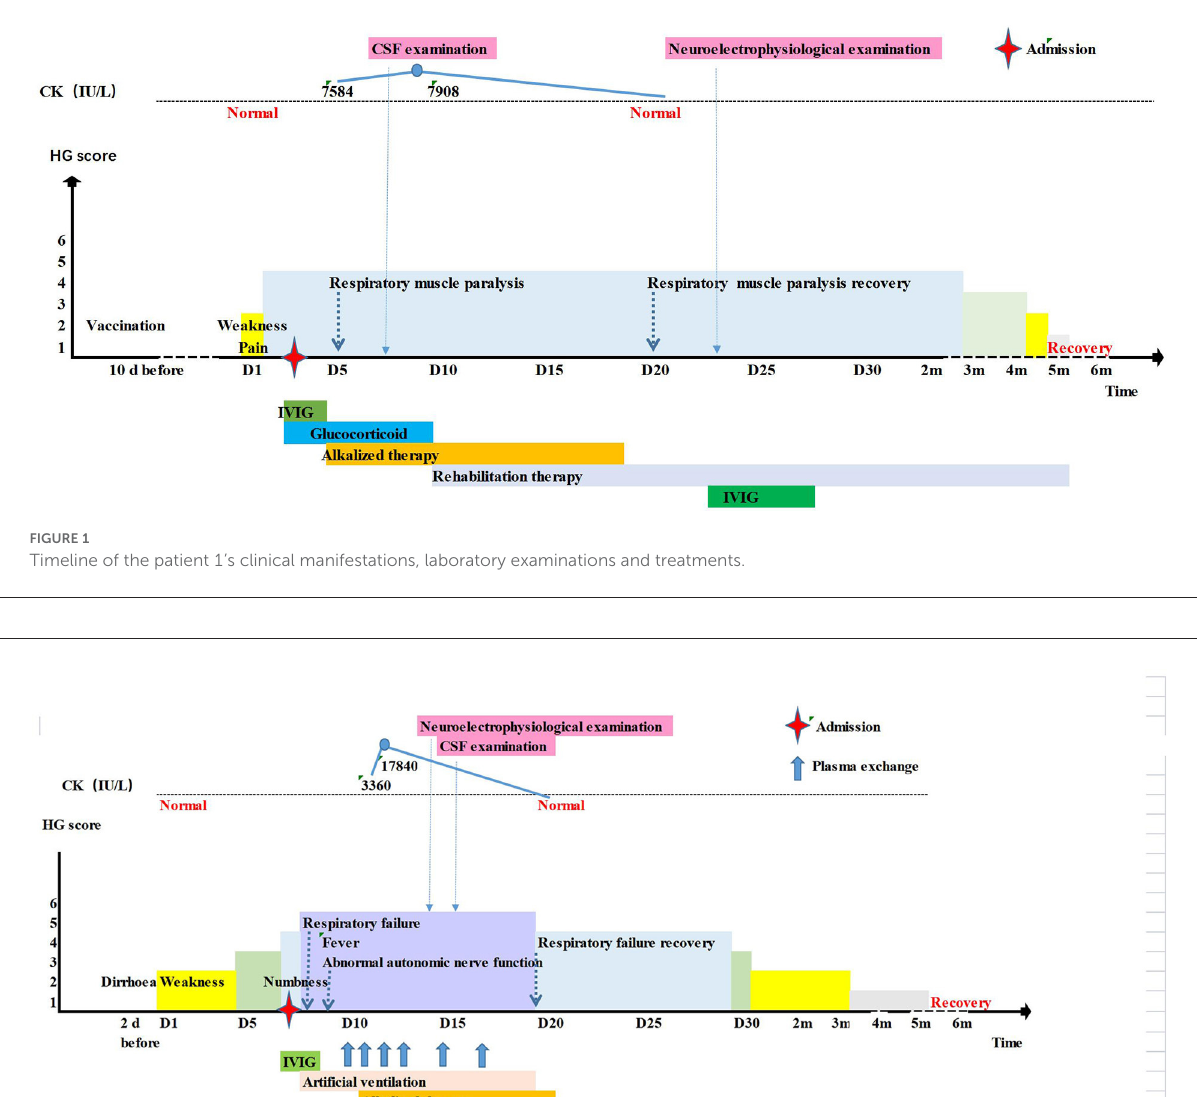
WBC count, and the serum anti-GM1 IgG antibody and anti-GD1b IgG antibody were positive. Starting on the 9th day, the patient’s condition improved gradually. On the 13th day, the patient underwent tracheotomy and artificial nasal ventilation. His muscle strength improved to grade IV, and the autonomic nerve dysfunction resolved. The CK returned to normal on the 15th day, and kidney function returned to normal on the 17th day. One month later, the boy could walk alone, his cranial nerve examination was normal. Five months later, he had full recovery of movement and sensation (Figure 2).